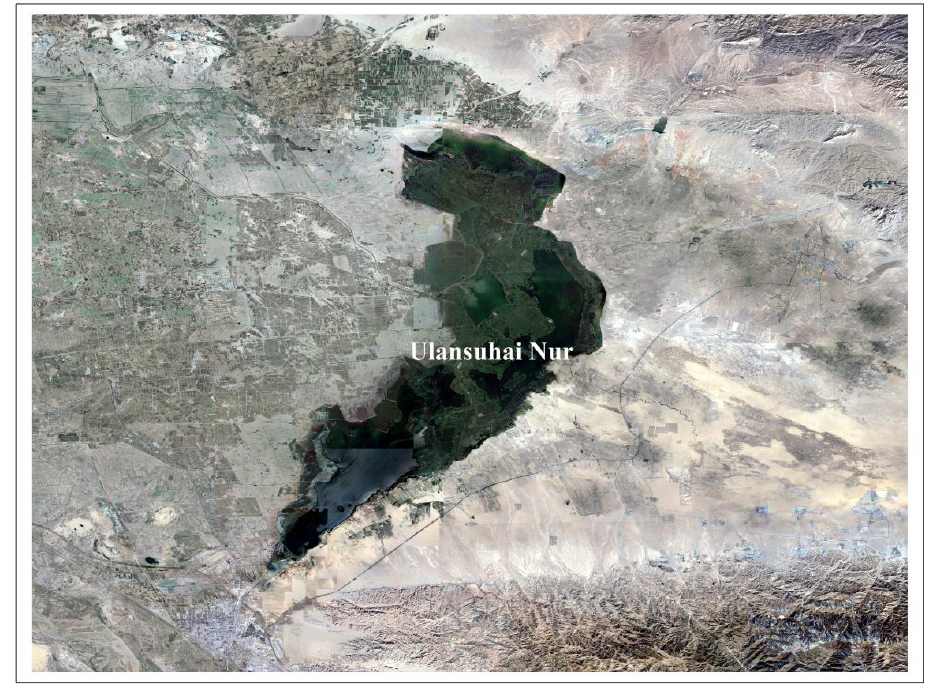
Figure 3. An aerial image of Ulansuhai Nur.